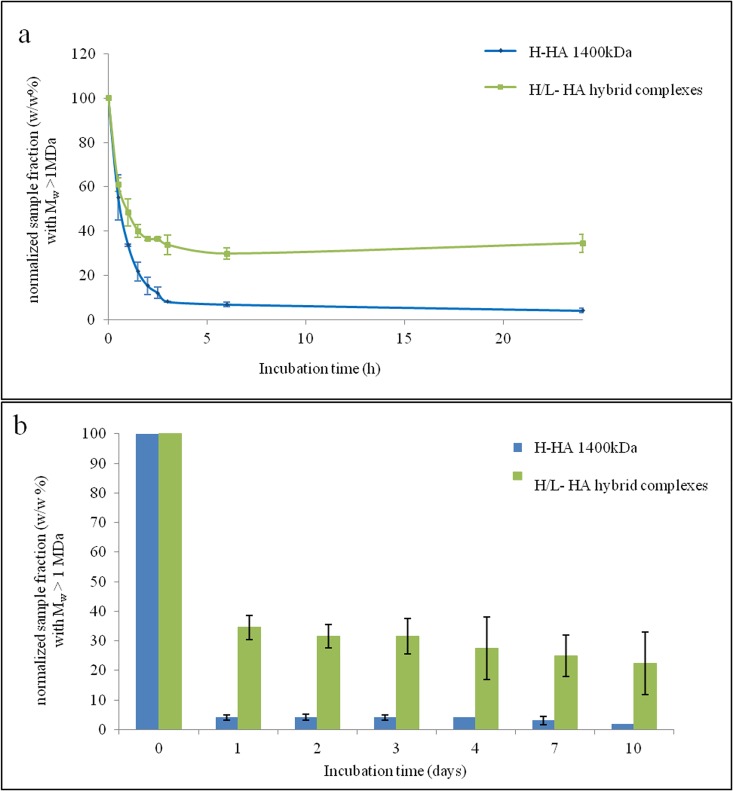
Results of sensitivity to enzymatic degradation for the hybrid cooperative complex and HHA: normalized sample fraction (w/w%) showing Mw higher than 1MDa during BTH 1U/mL action up to 24h (a) and 10days (b).